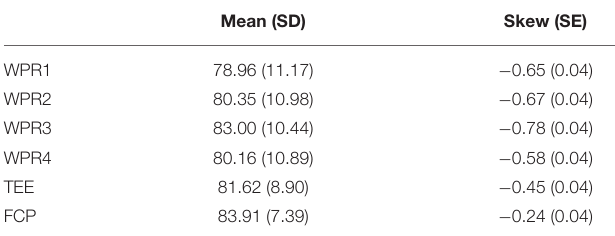
TABLE 2 | Descriptive statistics for WPRs, the TEE, and final course